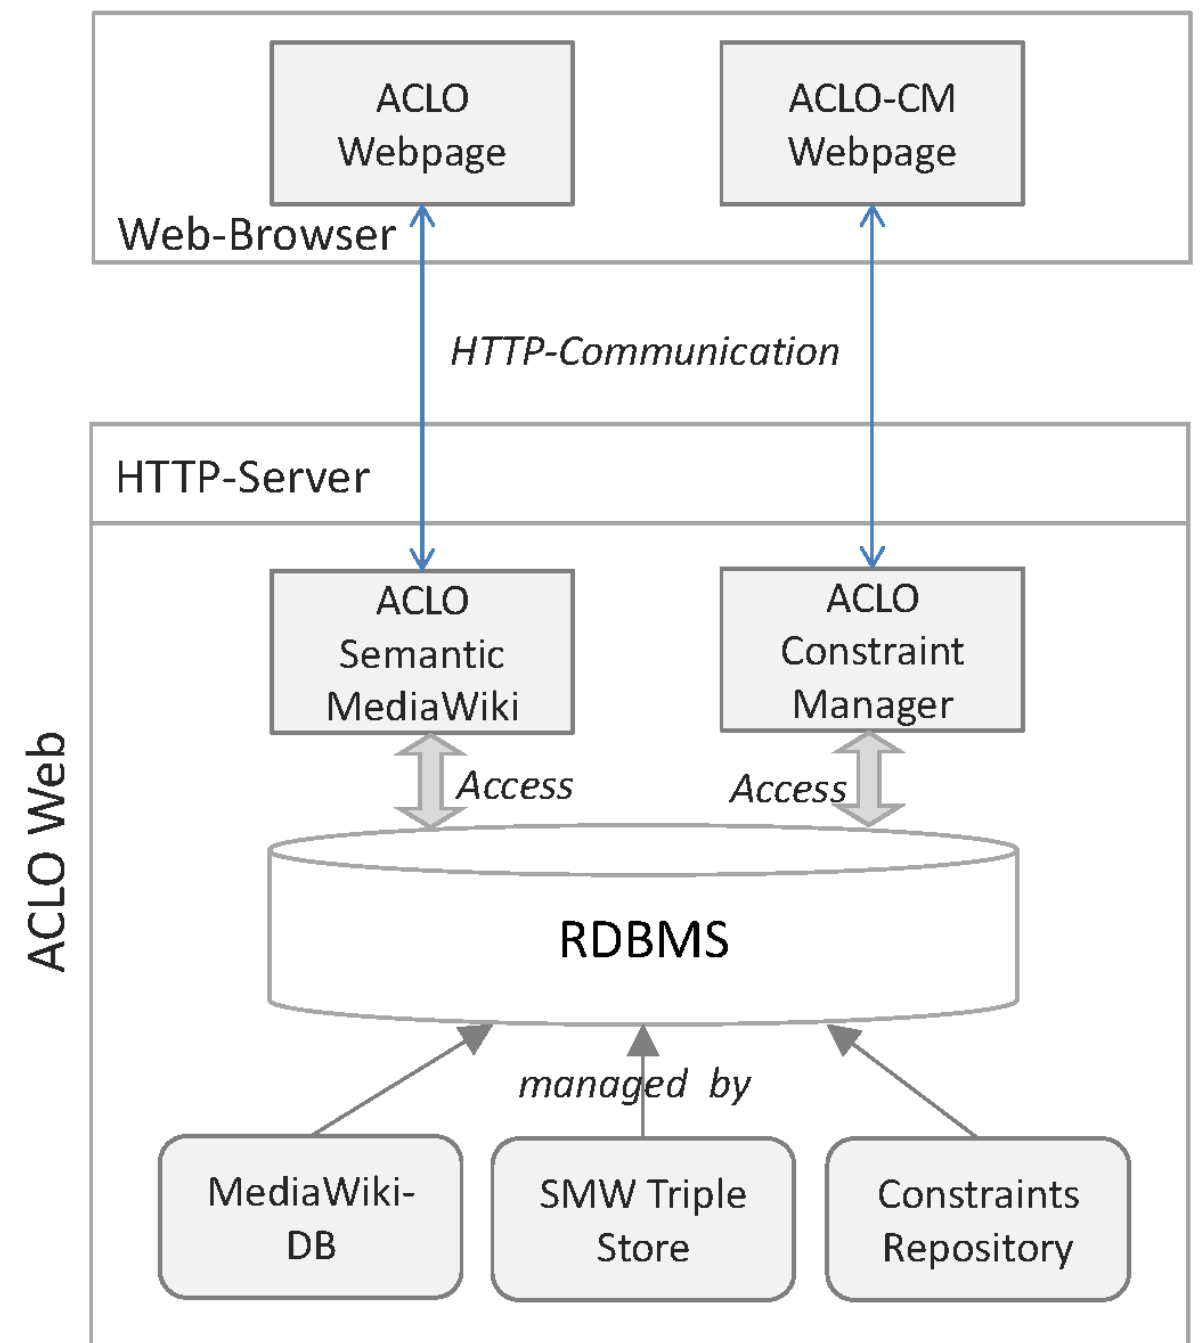
Figure 3. Architecture of